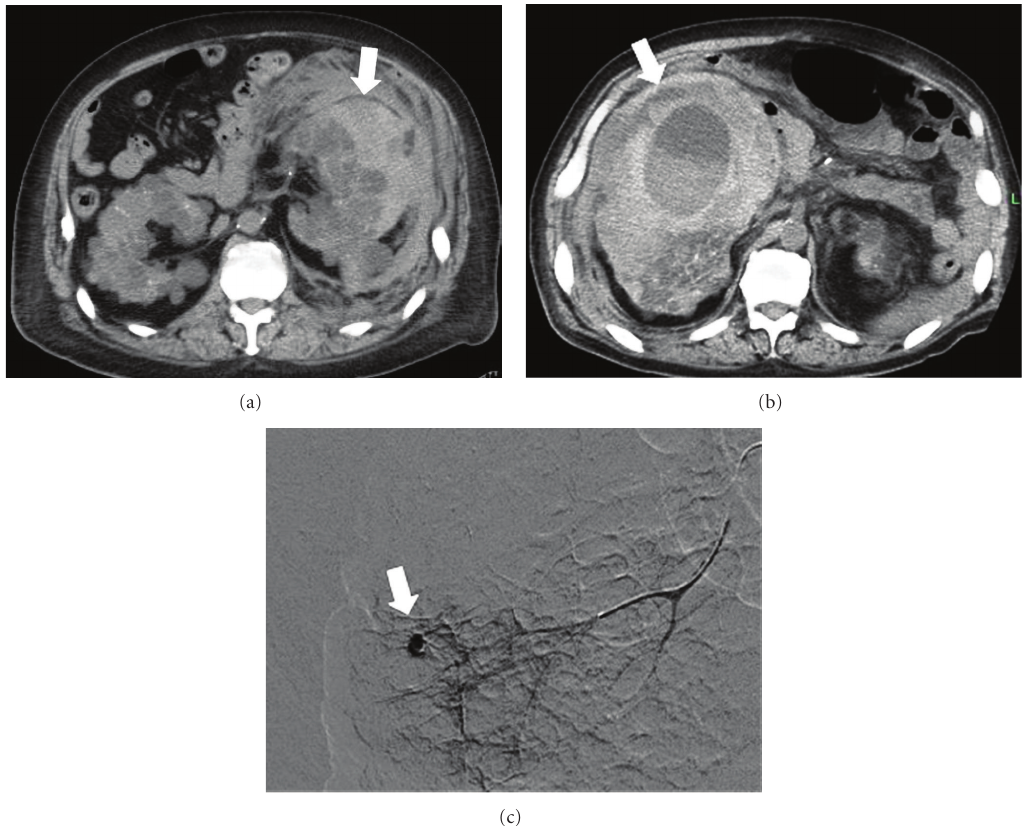
Figure 1: CT scan of the abdomen. (a) A large number of bilateral renal cysts were observed. A huge left perirenal hematoma (arrow) and (b) there was a large cyst including fluid with density of blood in right kidney, and a huge right perirenal hematoma (arrow). Renal arteriography during the right perirenal hemorrhage. (c) Extravasation from an aneurysm, being present at the periphery of right renal artery, was demonstrated